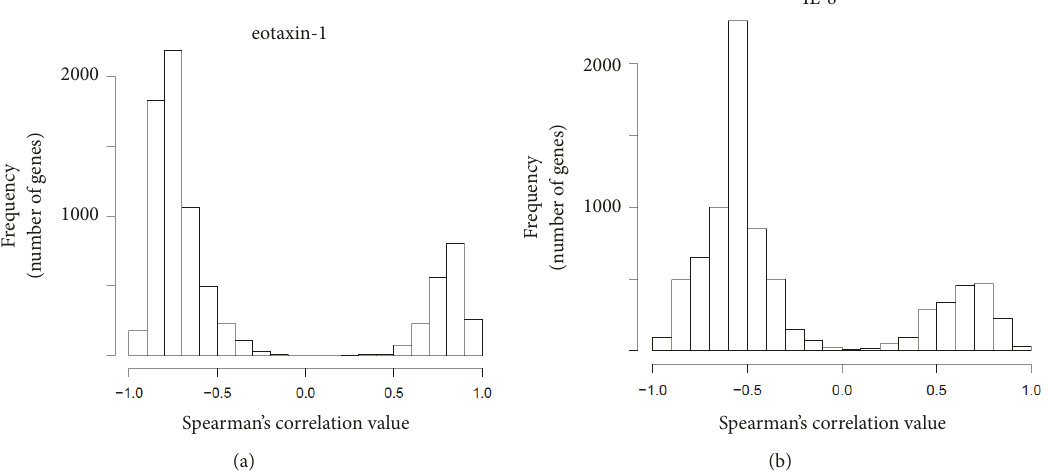
Figure 3: Spearman correlation coefficients between genes expressed by CD4+ cells. Genes expressed by CD4+ cells of CRC patients and healthy volunteers, with two-sided p-values, (a) eotaxin-1 and (b) IL-8